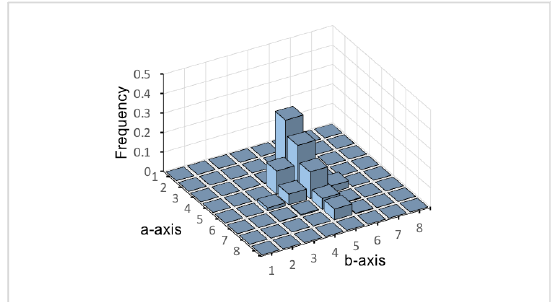
Figure 6. Mean color histogram.